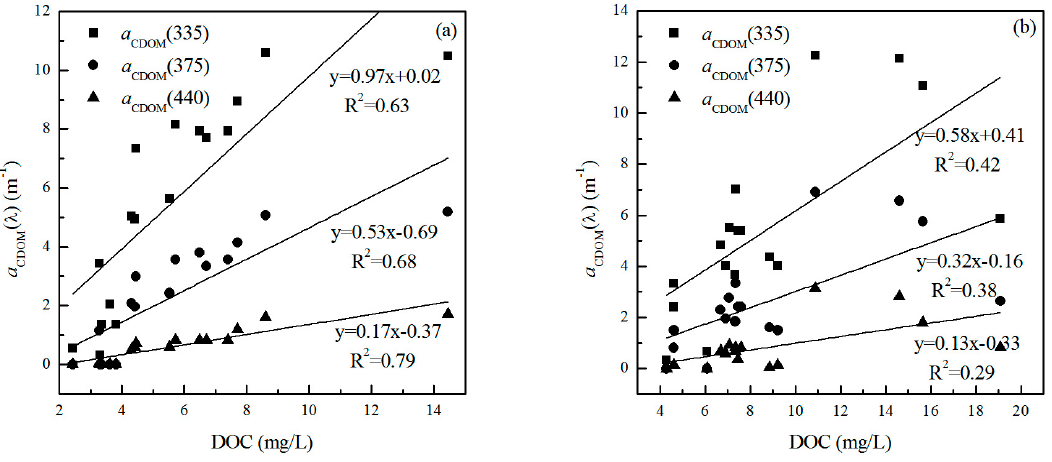
Figure 8. Correlations between a CDOM ( λ ) and DOC: ( a ) in summer; and ( b ) in autumn.